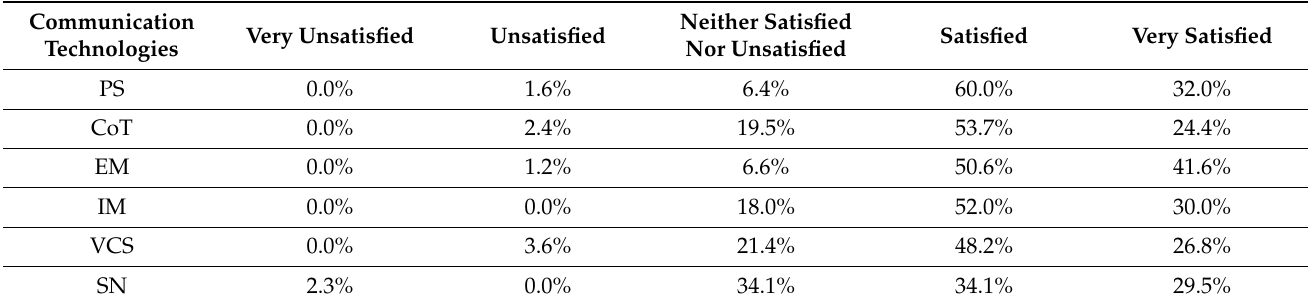
Table 26. Satisfaction on the use of communication technologies by teachers.